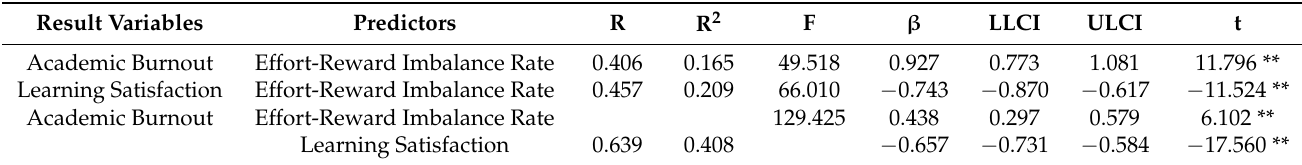
Table 2. Mediating model test of learning